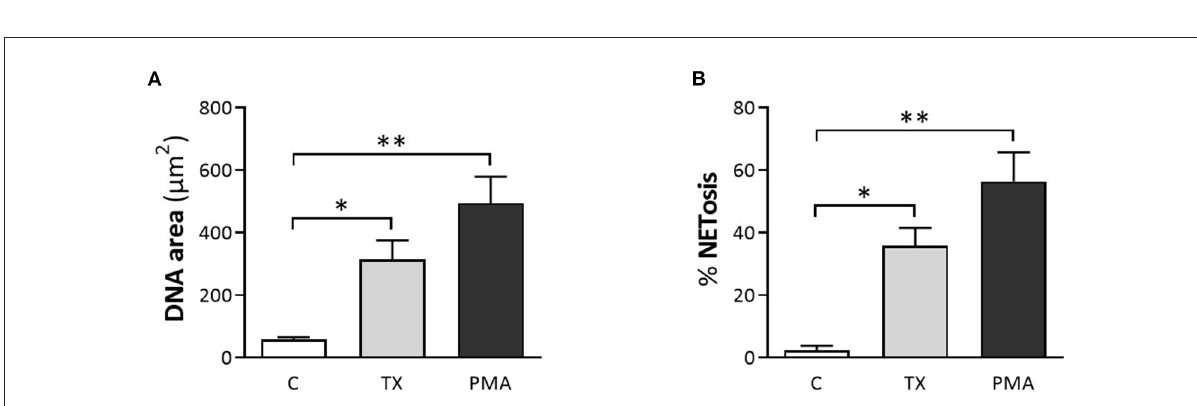
FIGURE3 Tamoxifen (TX) induced the formation and release of NETs quantified by DNA area and NETosis (DANA) analysis. (A) Quantification of DNA area ( µ m 2 ) and (B) percentage of NETosis for the three conditions studied. PMA (200 nM) was used as a positive control. Data are presented as mean ± standard deviation (SD). * p < 0.05, ** p < 0.01; n =